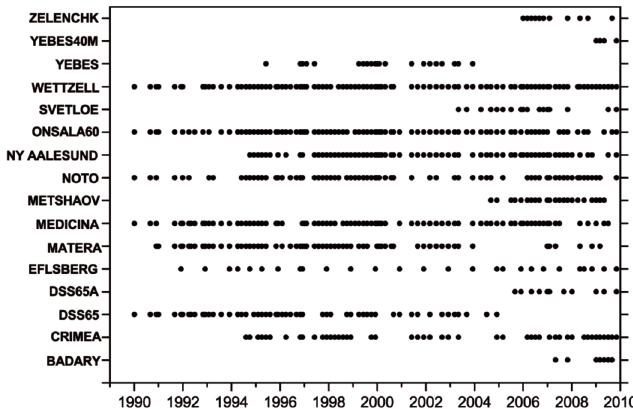
Figure 2. Participation of the VLBI stations in EUROPE-VLBI sessions. Black dots, sessions in which the VLBI stations